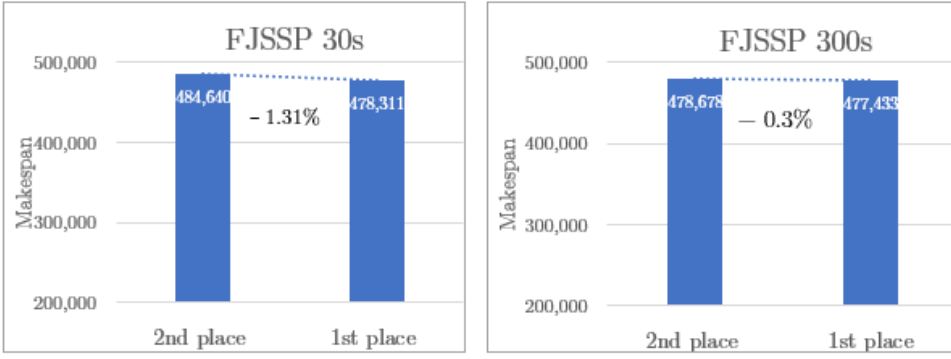
Figure 6. Makespan differences by algorithm selection per instance for FJSSP.